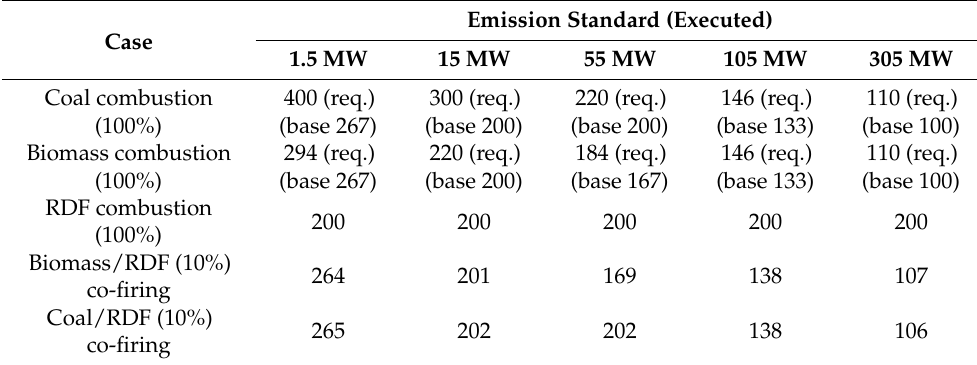
Table 5. The results of the emission standards estimation for NO x (mg/m 3 , 11% O 2 , STP), the cases of individual combustion and co-firing, RDF share 0% – 100% (by energy).